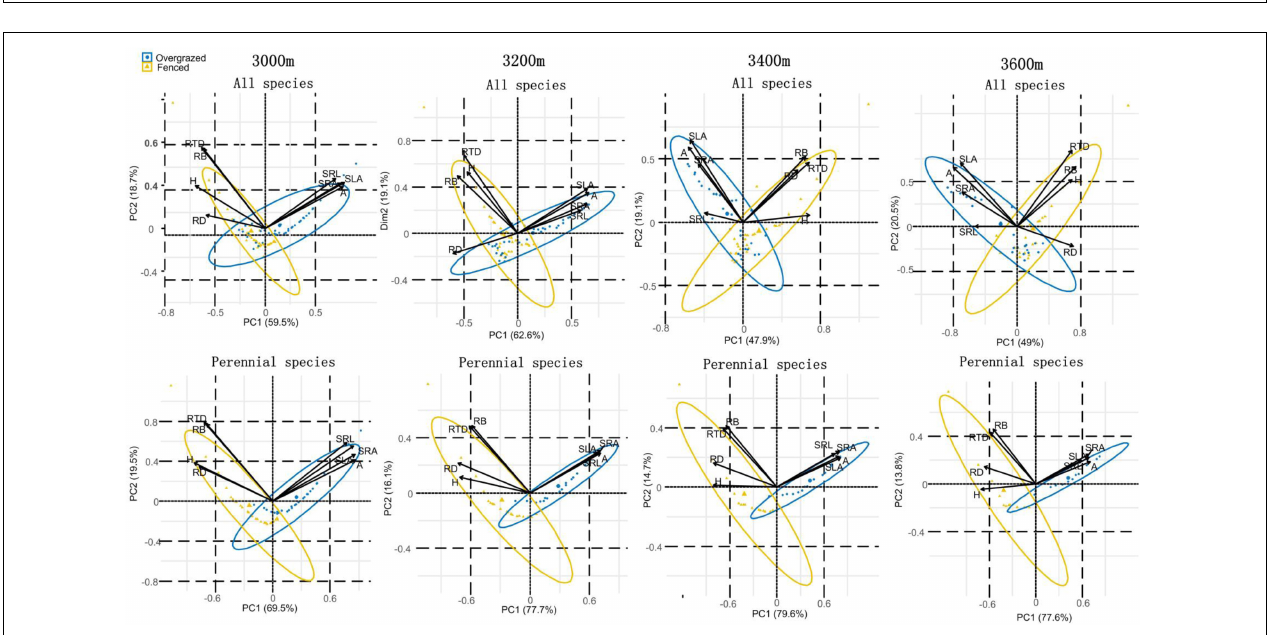
FIGURE 4 | Principal component analysis of below-ground (RD, RB, SRL, SRA, and RTD) and above-ground traits (H, A, and SLA) in fenced and overgrazed meadows for all species, and separately for perennial species from 3000 to 3600 m elevations.